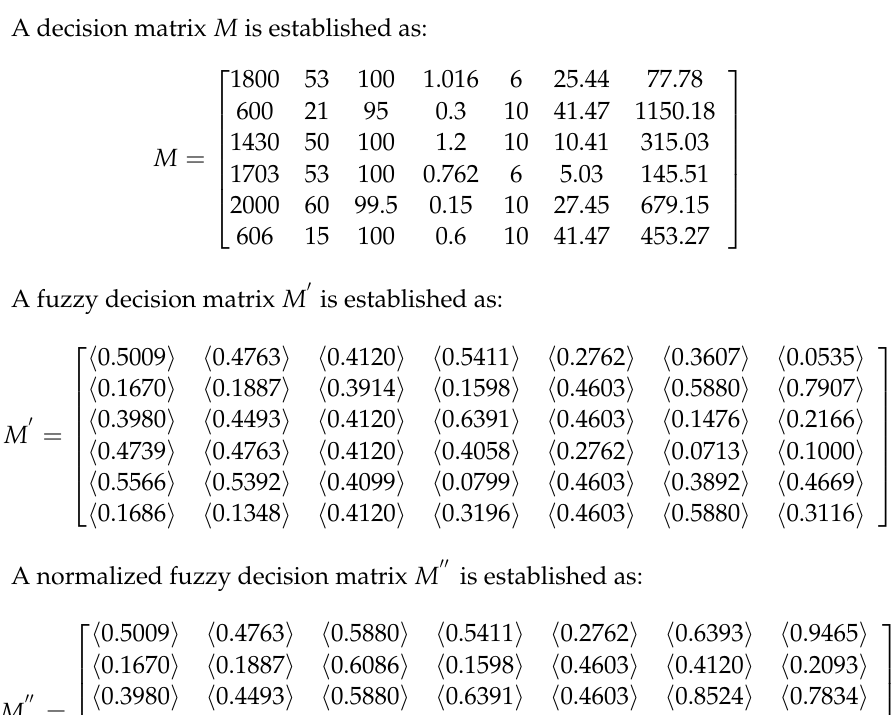
Figure 3. Automatic generation of attribute values for Example 1.